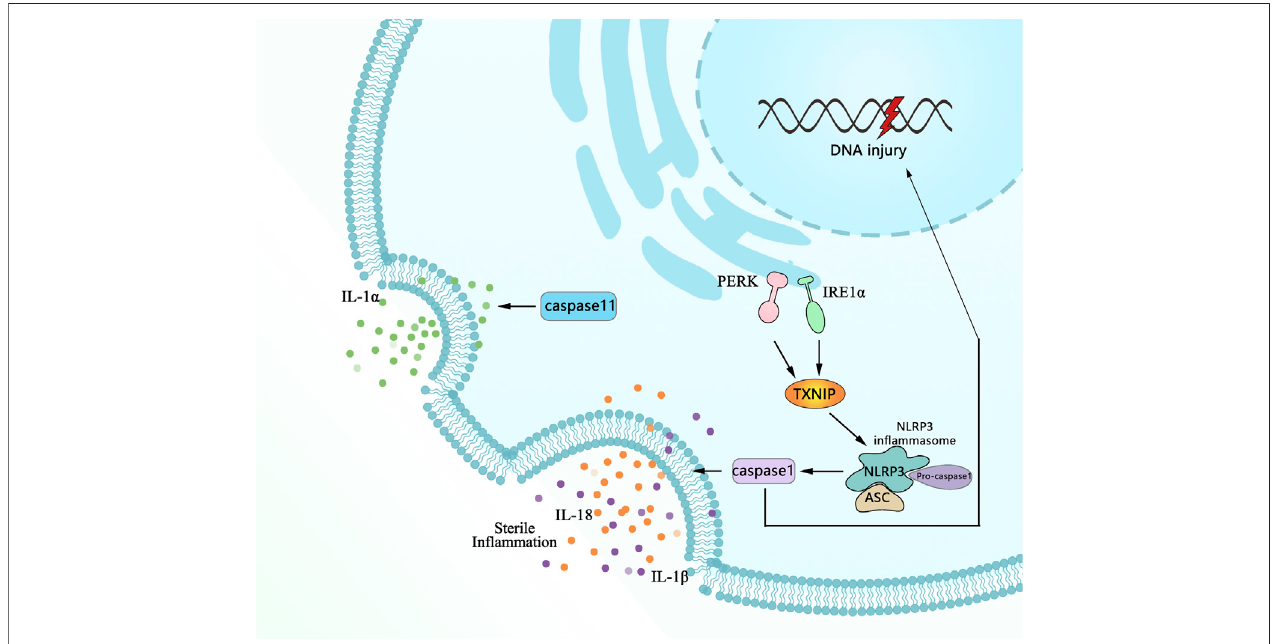
FIGURE4| SchematichighlightsofthecomplexnetworkonmultiplefactorsinvolvedinsignalingpathwaysforERstress-inducedpyroptosis.Followinginjury,pro- in fl ammatory mediators of proIL-1 β , NLRP3, and caspase-11 are increased transcription. ProIL-1 β and TXNIP facilitate the assembly and activation of the NLRP3 in fl ammasome that cleaves procaspase-1 toactive caspase-1, which in turn leads toprocess maturation ofthe IL-1 β and initiating pyroptosis with thefeatureof plasma membrane rupture and DNA fragmentation along with multifarious cytopathological changes.